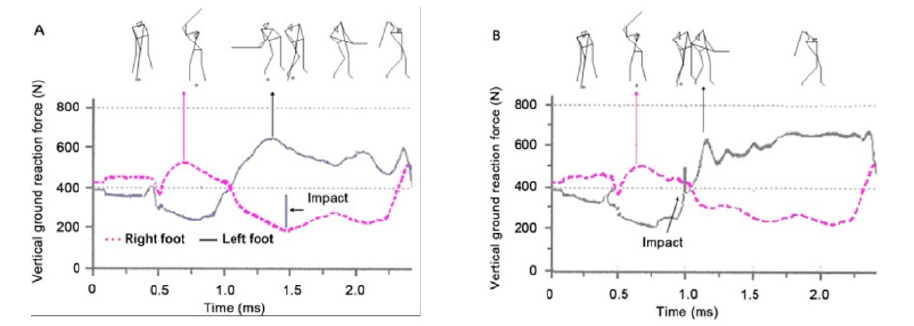
Fig. 10 Timing diagram of left arm motion correlation